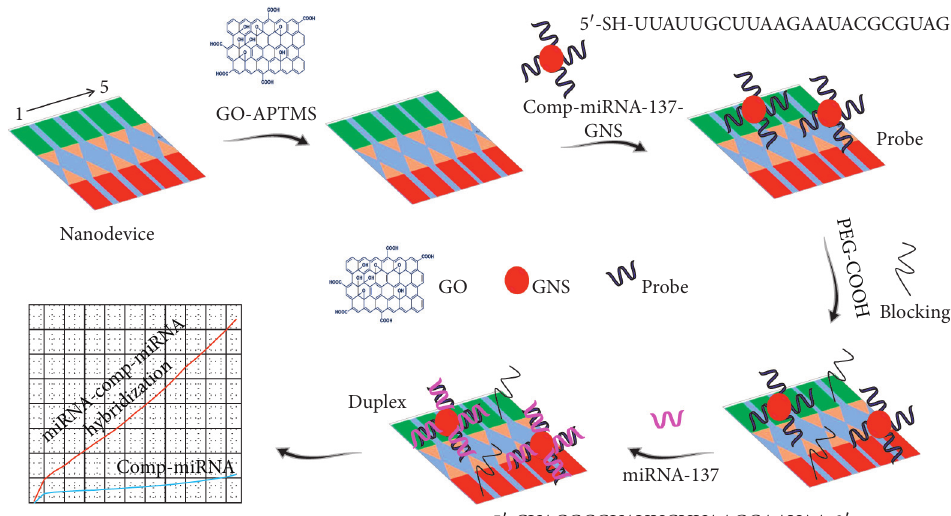
Figure 1: Schematic illustration of miRNA-137 determination. Sensing substrate was modified into APTMS-GO, and then, gold nanostar- conjugated complementary of miRNA-137 (GNS-probe) was attached and then detected by miRNA-137 complementation. A set of five devices is shown.